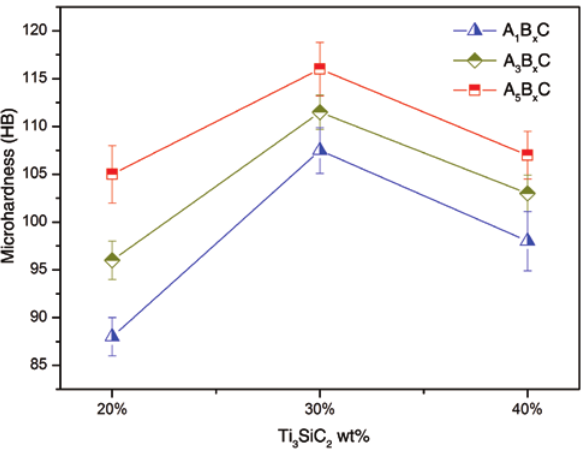
SiC /Al O 3 2 2 3